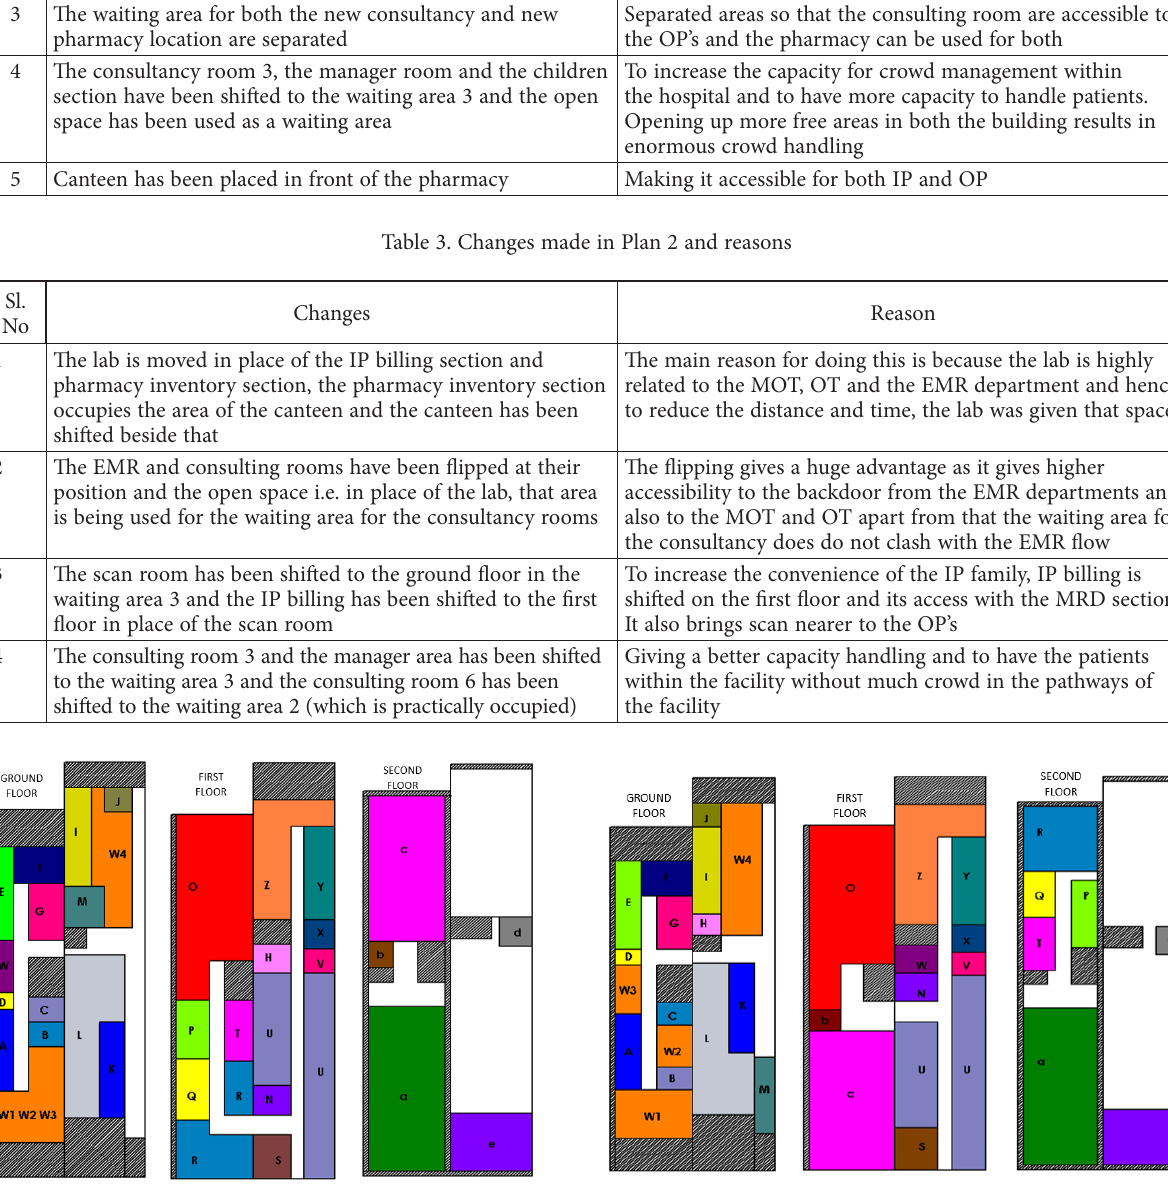
Figure 4. Proposed layout 2 (Plan Figure 5. Proposed layout 3 (Plan